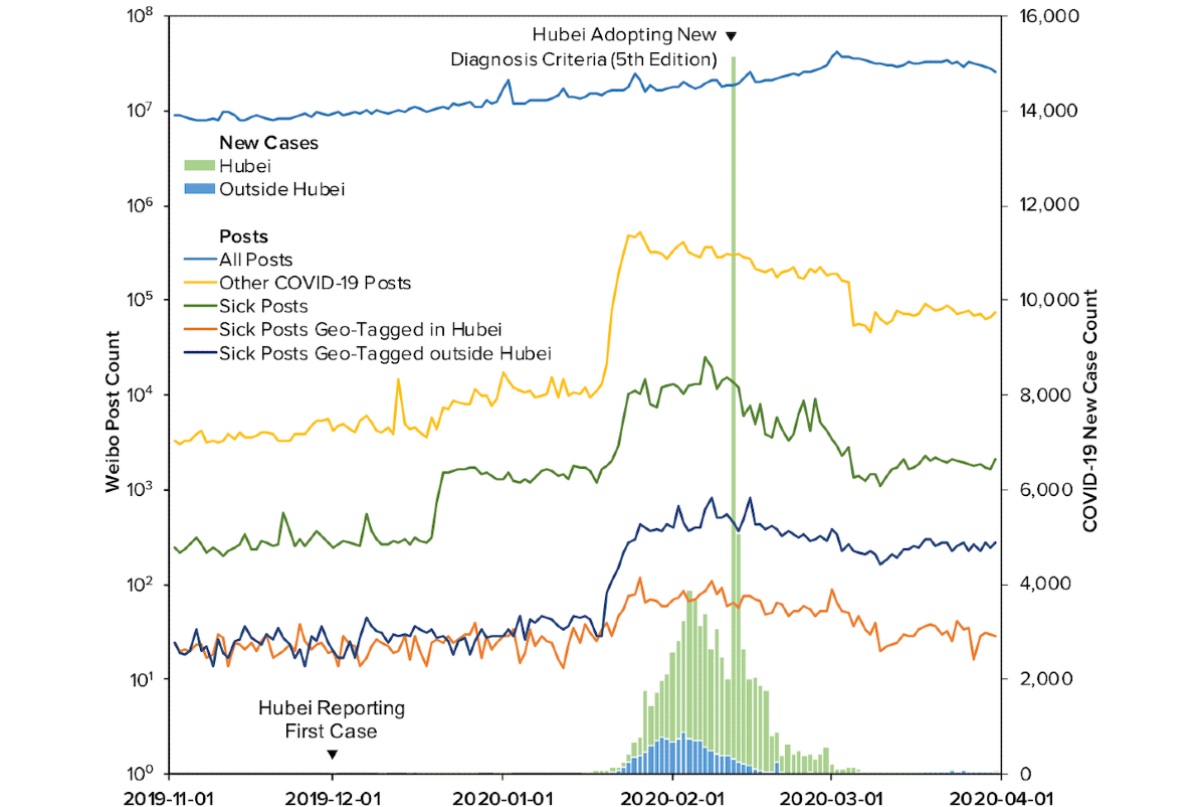
Figure 3. Daily Weibo posts and confirmed COVID-19 cases between November 1, 2019 and March 31,